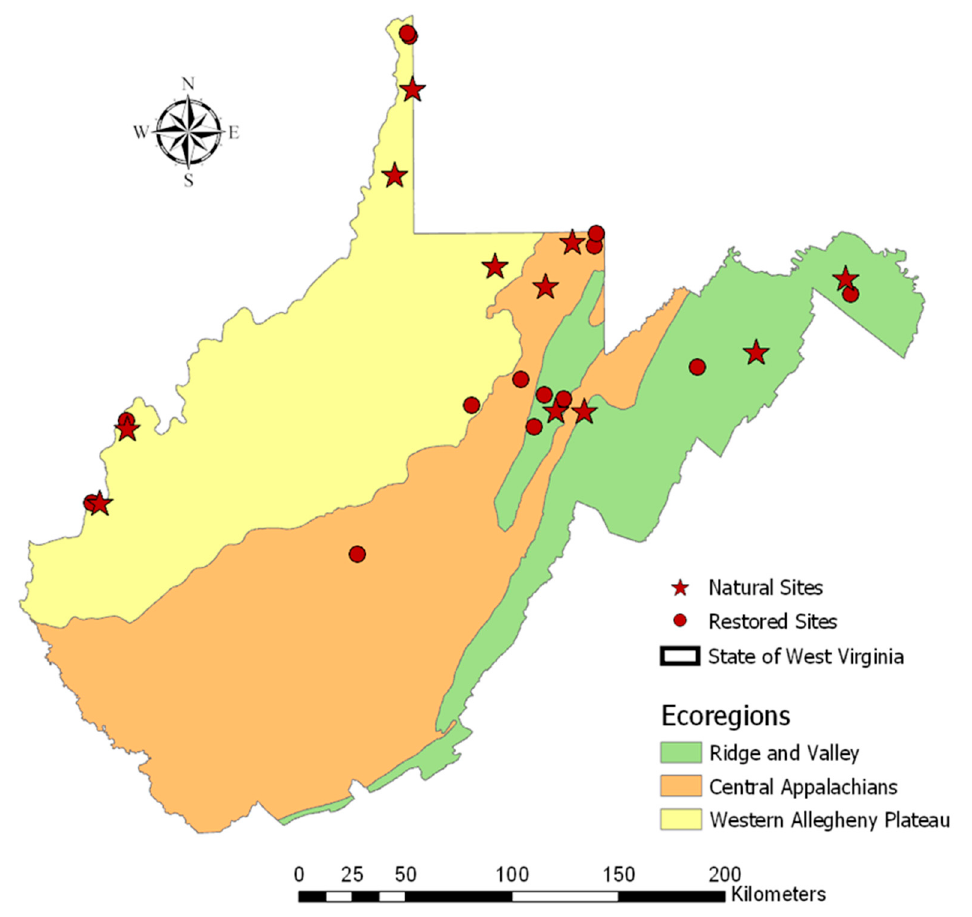
Figure 1. Twenty-six wetland sites (14 restored and 12 natural) were sampled in 2020 and 2021 for small mammal and vegetation communities throughout West Virginia, USA. Sites are plotted against the state’s three ecoregions: Ridge and Valley, Central Appalachians, and the Western Allegheny Plateau.